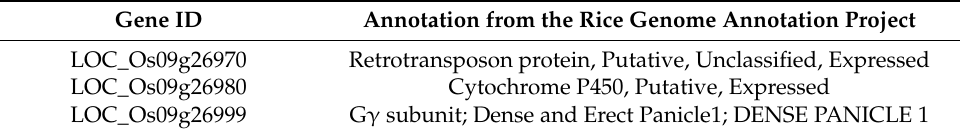
Table 4. Annotated genes included in the 16.17kb region for qLL9 .